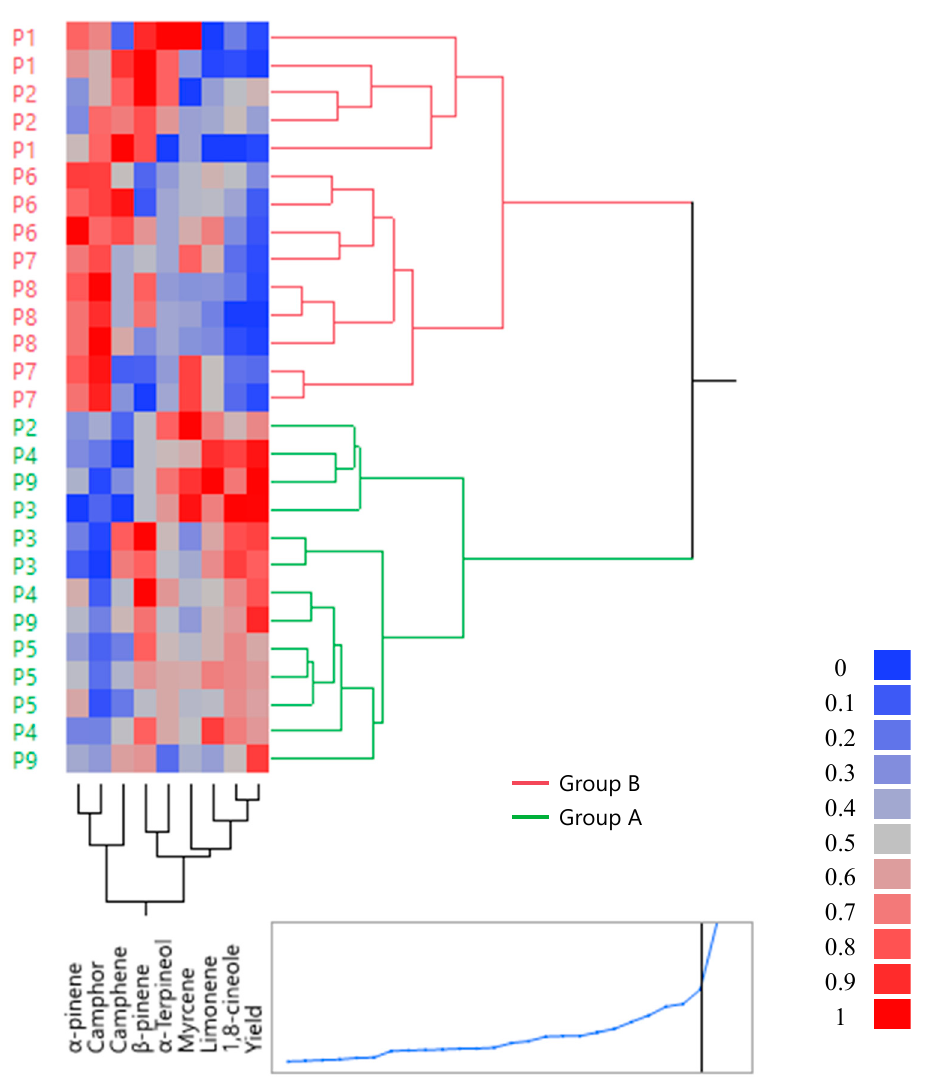
Figure 5. Hierarchical group analysis of samples of S. rosmarinus based on the method of ward. Group A represents the summer season. Group B represents the winter season.